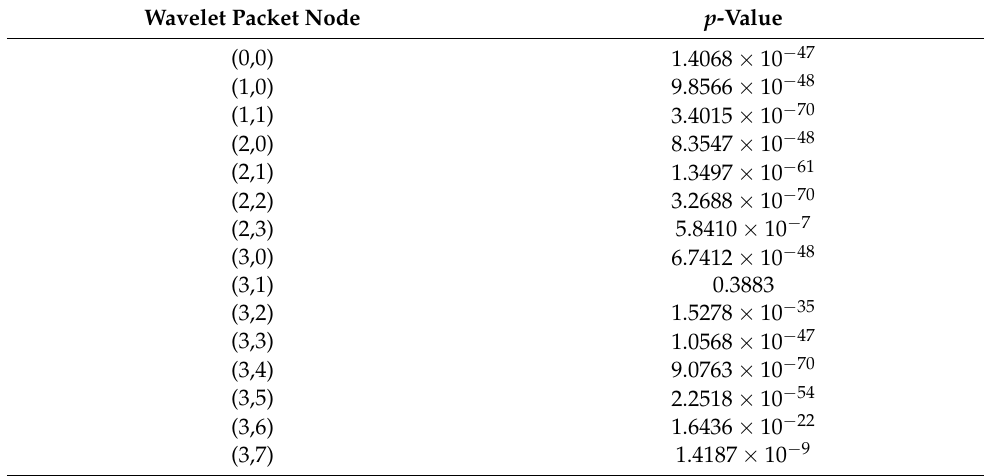
Table 2. Different signals wavelet packet nodes entropy Kruskal–Wallis test p